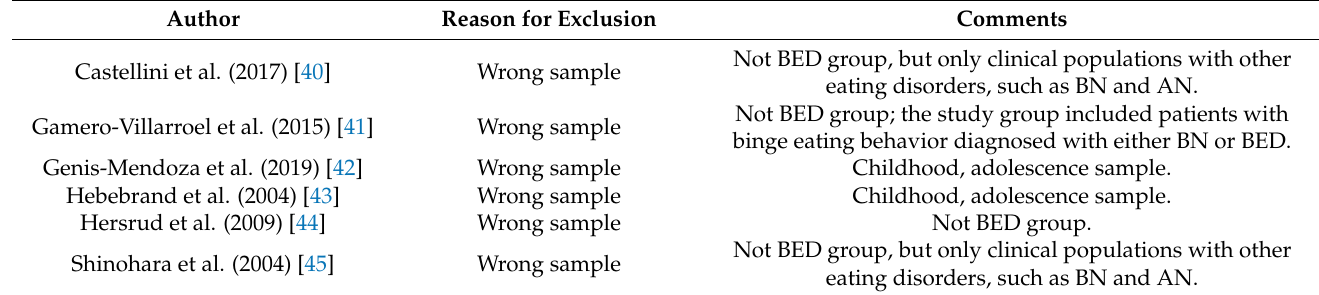
Table A1. Reason for